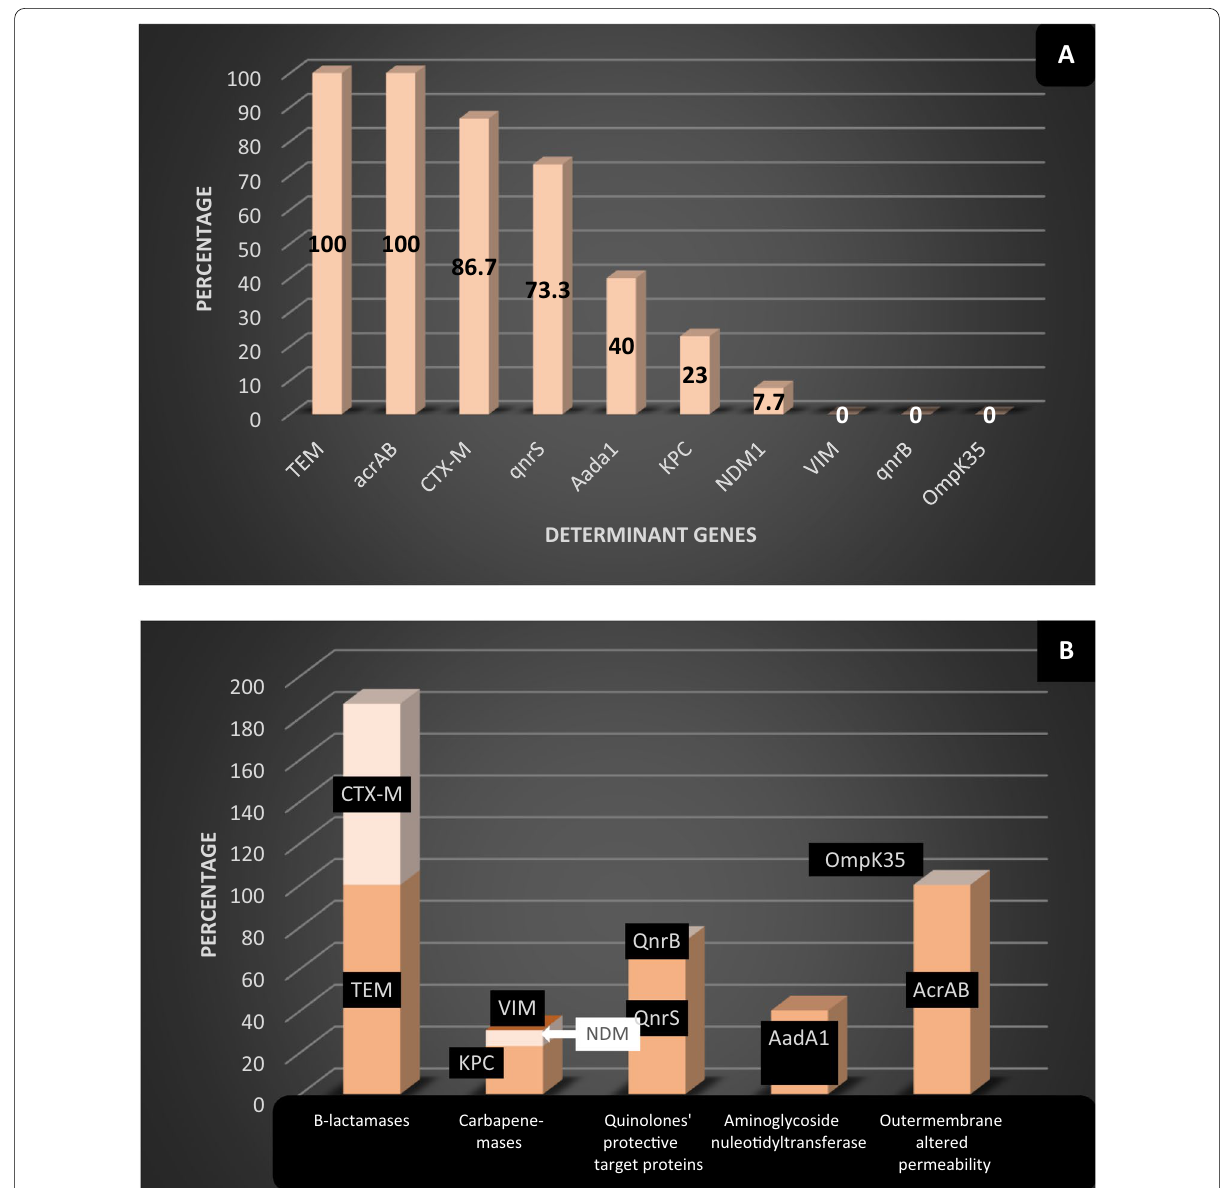
Fig. 1 A Incidence of the multidrug resistance determinants, B Incidence of multidrug resistance